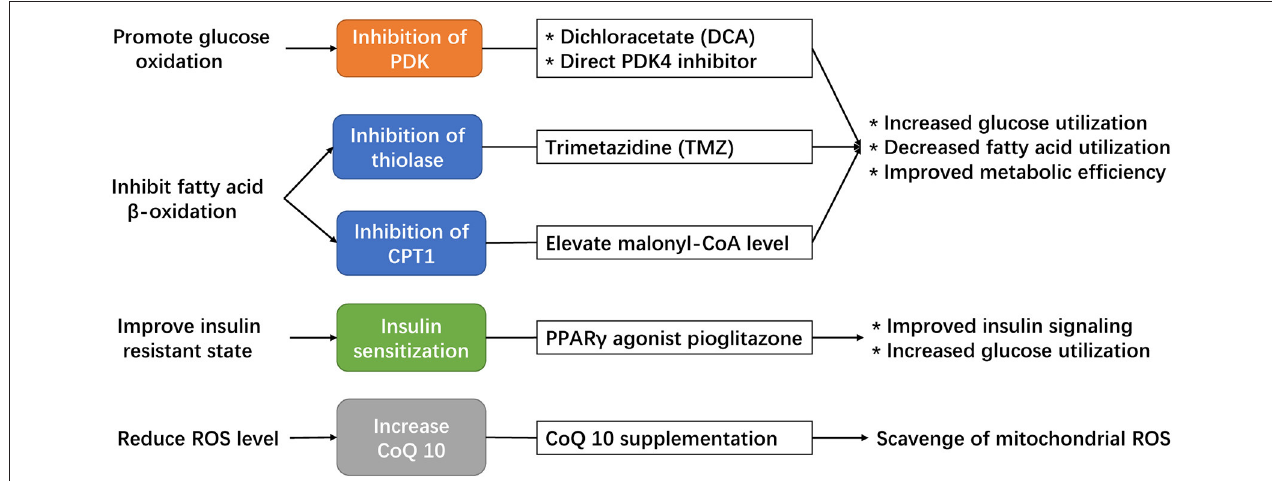
FIGURE 4 | Potential strategies available to modulate the adaptive cardiac metabolism under chronic